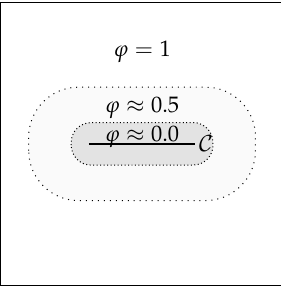
Figure 1. Computational domain D with inscribed fracture C and its phase-field approximation. The unknown displacement field u : D → R d and fracture ϕ : D → [ 0, 1 ] are computed by means of an energy minimization problem (cid:90) G c 1 E ( u , ϕ ) = ( (cid:107) 1 − ϕ (cid:107) 2 + ε (cid:107)∇ ϕ (cid:107) 2 ) → min, g ( ϕ ) E s ( e ) dx + ε 2 D with additional displacement boundary conditions on ∂ D